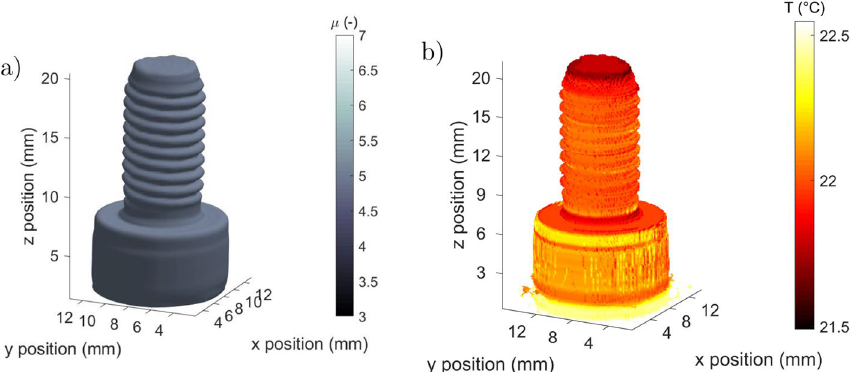
Figure 5. Reconstructed three-dimensional maps of the M6 screw sample: ( a ) absorptivity tomography at (cid:31) = 4 μm and ( b ) temperature map in °C at the surface of the sample. (Created with MATLAB 2020a, https :// mathw